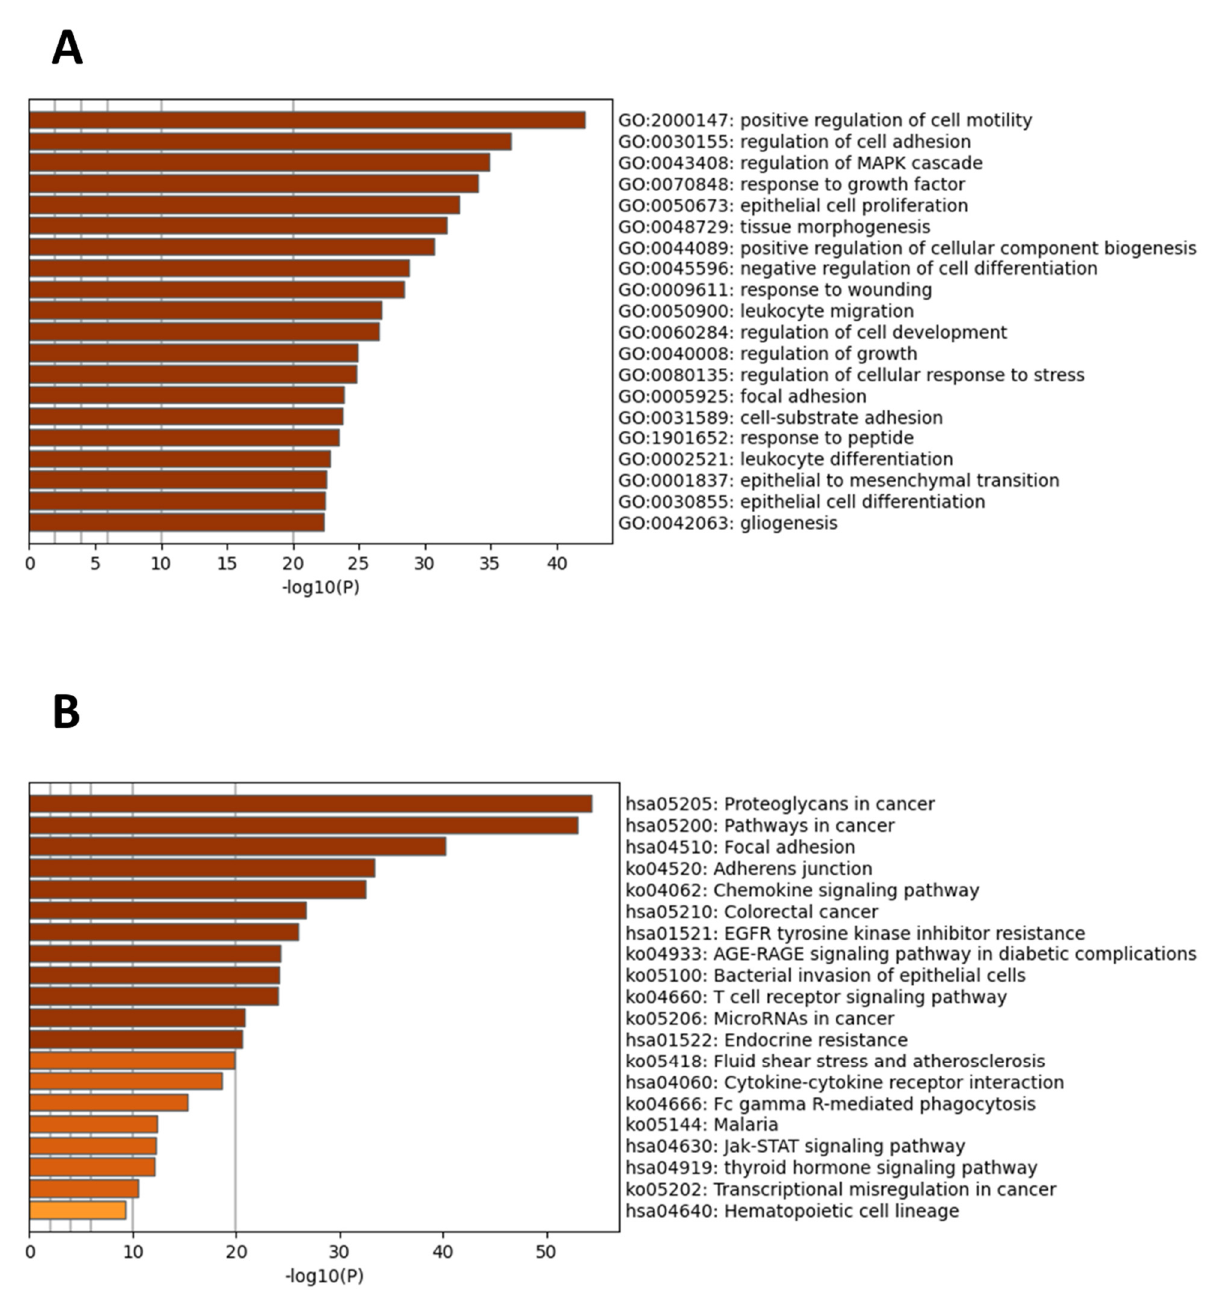
Figure 4. Significant gene ontology enrichment terms and enriched pathways of the candidate hub genes. ( A ) Top 20 GO terms. ( B ) Top 20 enriched KEGG pathways. GO and pathway analysis was acquired from the Metascape tool. p < 0.01. Dark colors represent a significant enrichment of more genes compared to lighter